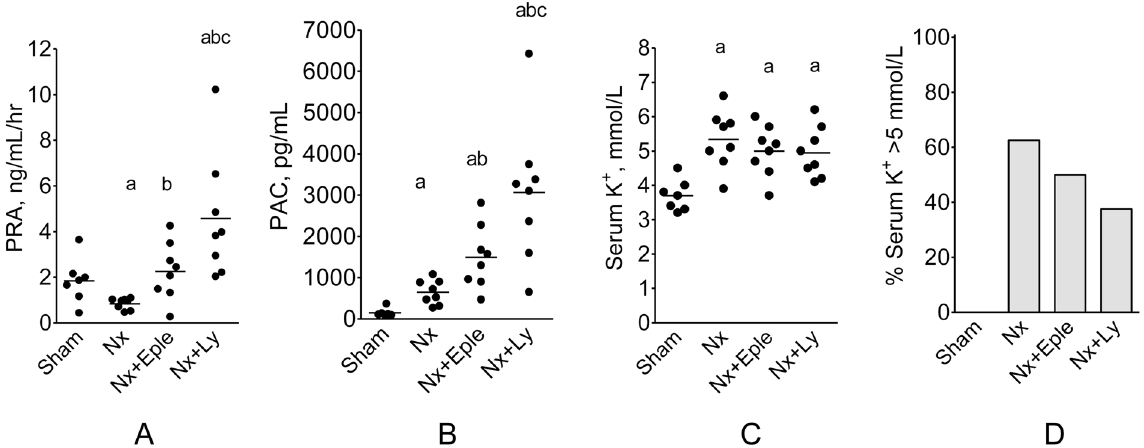
Figure 4. Plasma renin activity (PRA, ( A ), Plasma Aldosterone Concentration (PAC, ( B ), serum K + ( C ) and percent hyperkalemia, defined as serum K + > 5 mmol/L ( D ) 60 days after renal ablation in Protocol 1 (early treatment). a p < 0.05 vs. Sham, b p < 0.05 vs. Nx, c p < 0.05 vs. Nx + Eple.